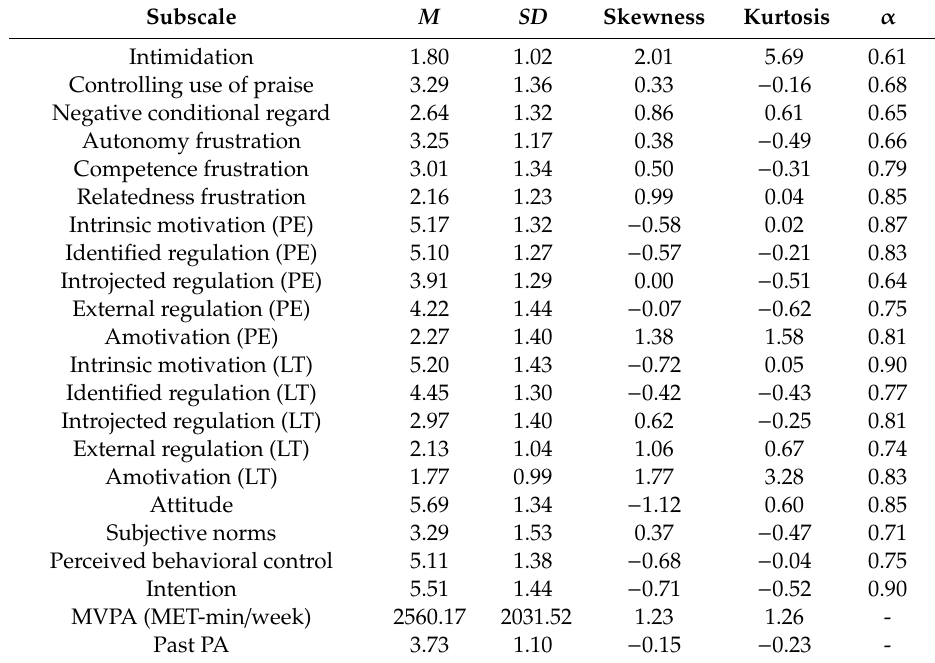
Table 1. Descriptive statistics and reliability coe ffi cients for each